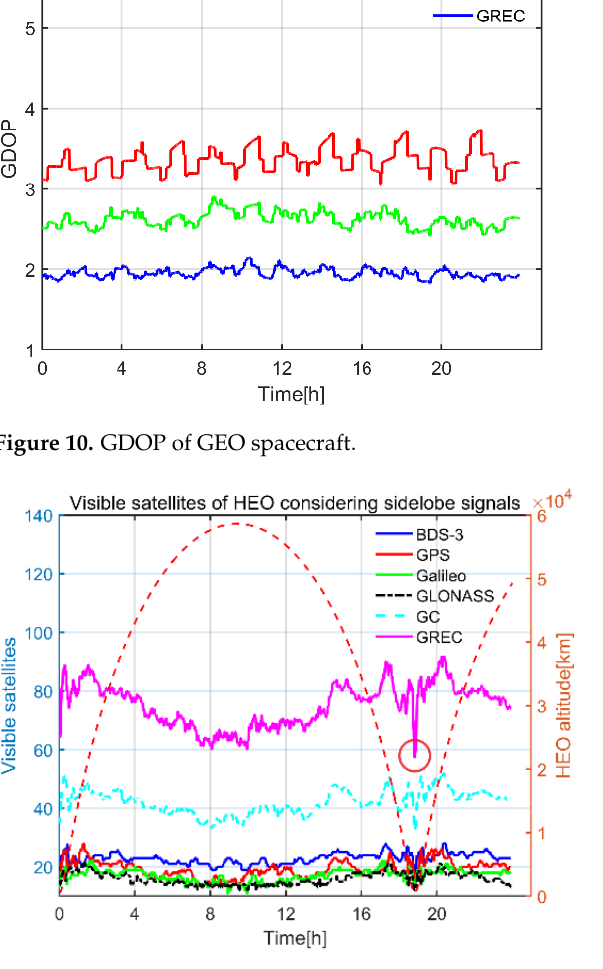
Figure 11. Visible satellites. GDOP of the HEO spacecraft is shown in Figure 13, it rose and fell. We obtained the best satellite geometry near perigee, and the worst satellite geometry near apogee. GDOP of BDS-3 ranged from 0.96~6.64. With GPS included, GDOP decreased to 0.71~5.30. GDOP of GREC combination varied from 0.52~4.42. Mean GDOP of BDS-3, BDS-3/GPS and GREC combination was 3.57, 2.88 and 2.3, respectively. This good satellite geometry also resulted from the large number of visible satellites. For the HEO spacecraft, nadir- and zenith-pointing antennas were mounted; therefore, good satellite visibility could be